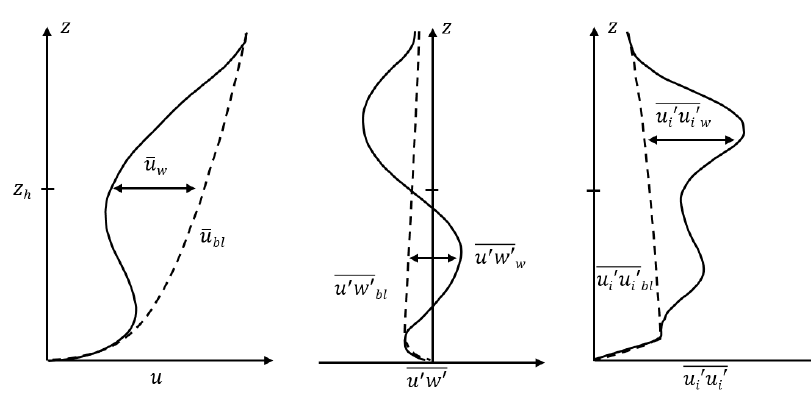
Figure 1. Sketch of the two superimposed flow